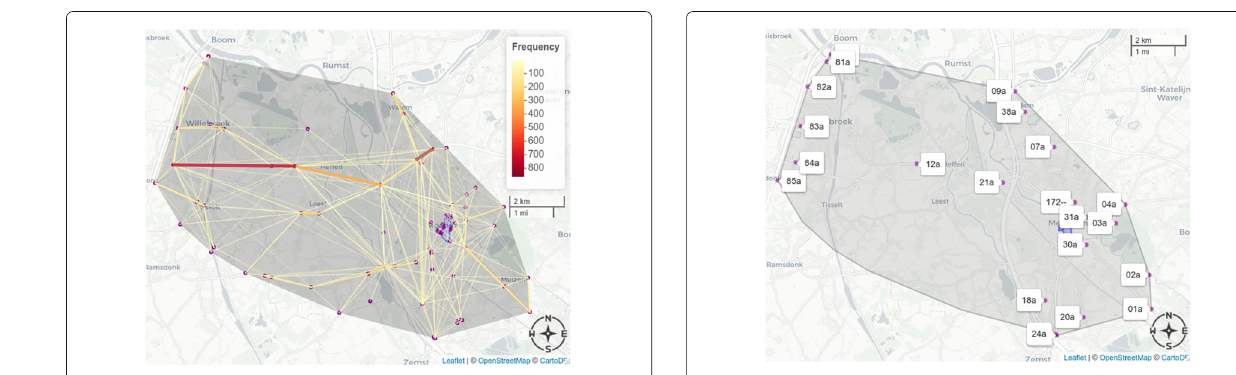
Fig. 12 LGVs trajectories Fig. 14 Map of top cameras in Entry-Exit